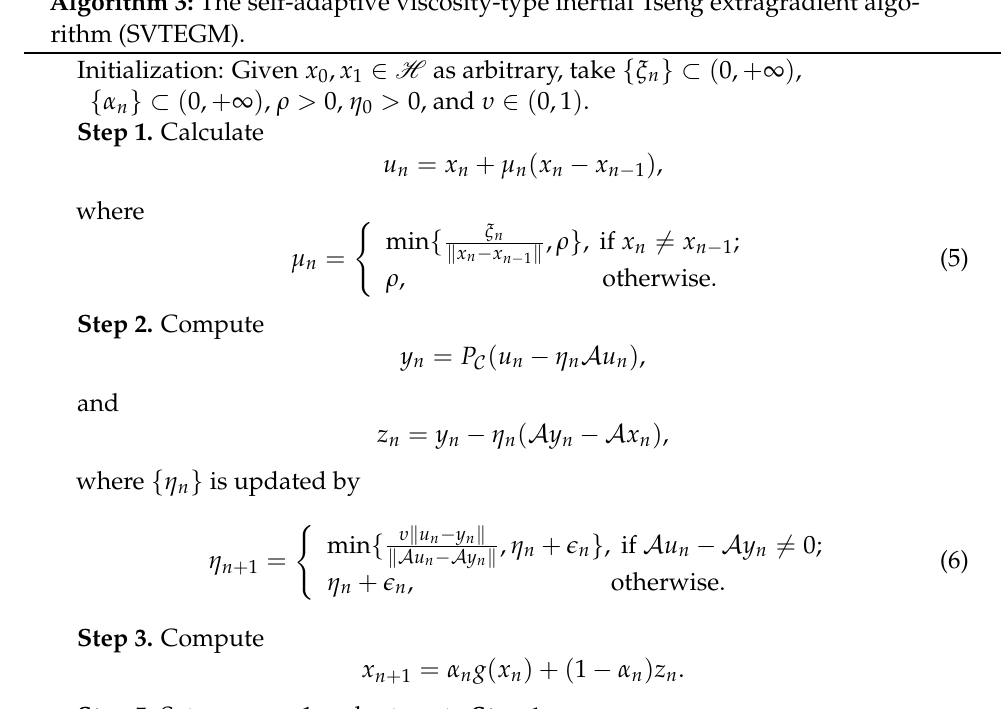
Algorithm 3: The self-adaptive viscosity-type inertial Tseng extragradient algo- rithm